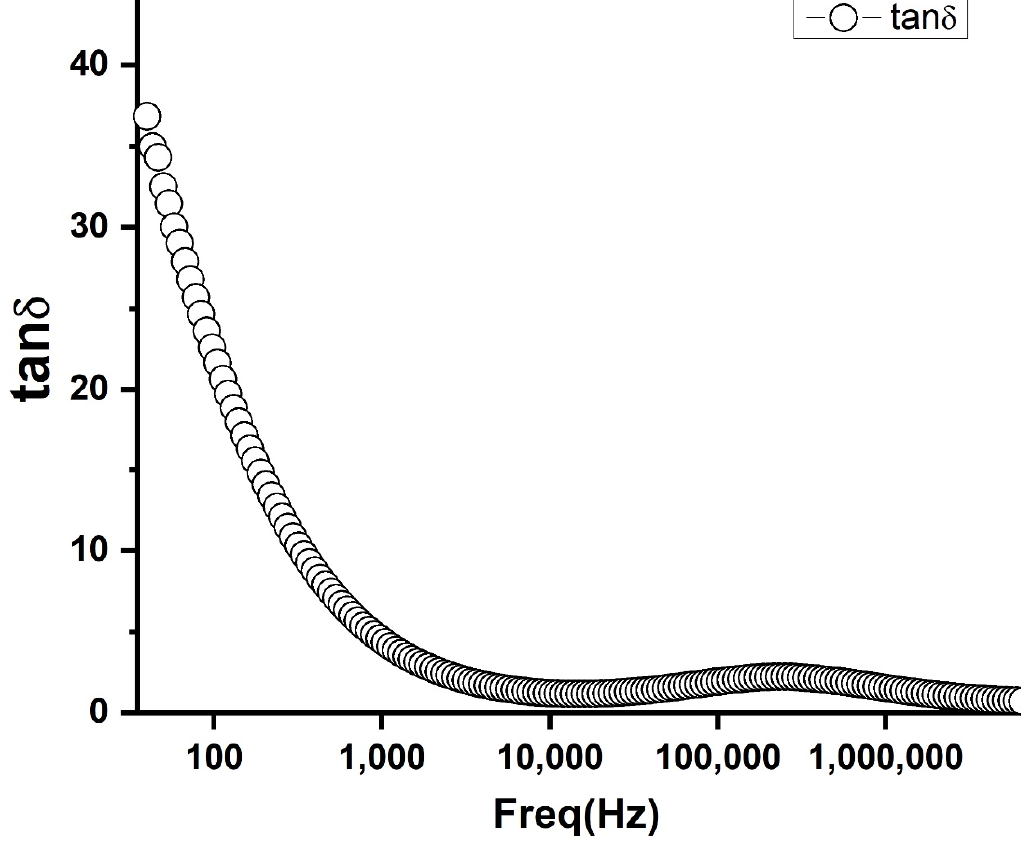
Figure 9. Tan loss as a function of frequency for PbS.